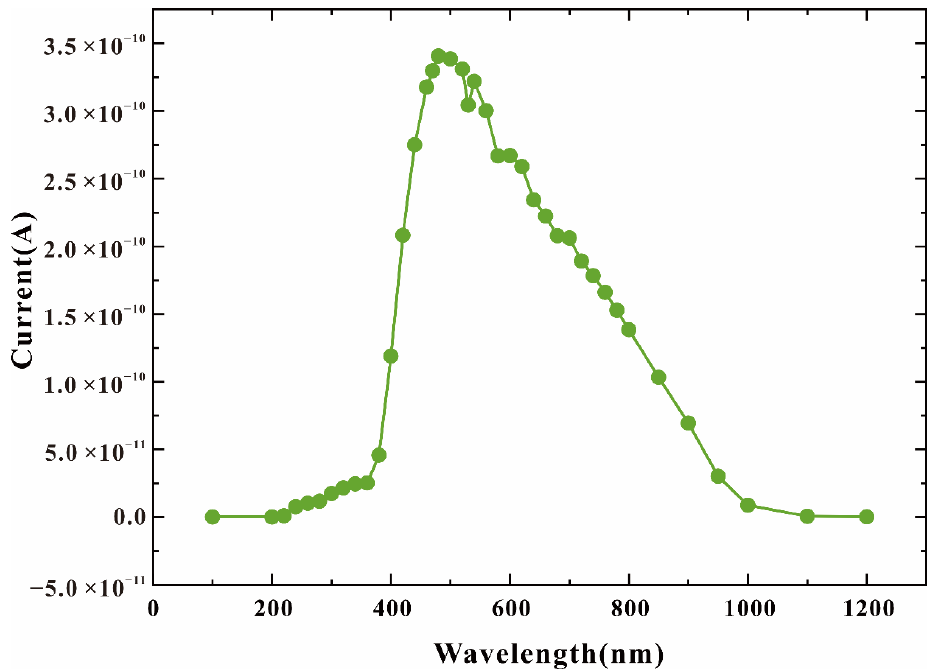
Figure 6. Spectral simulation curve of HDEPD device.